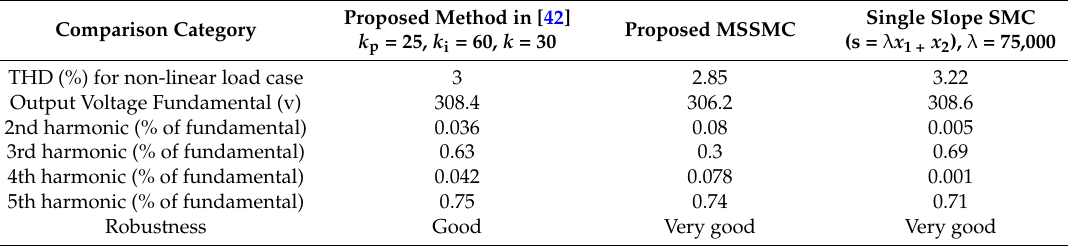
Table 2. THD (total harmonic distortion) and harmonics of the output voltage for three control